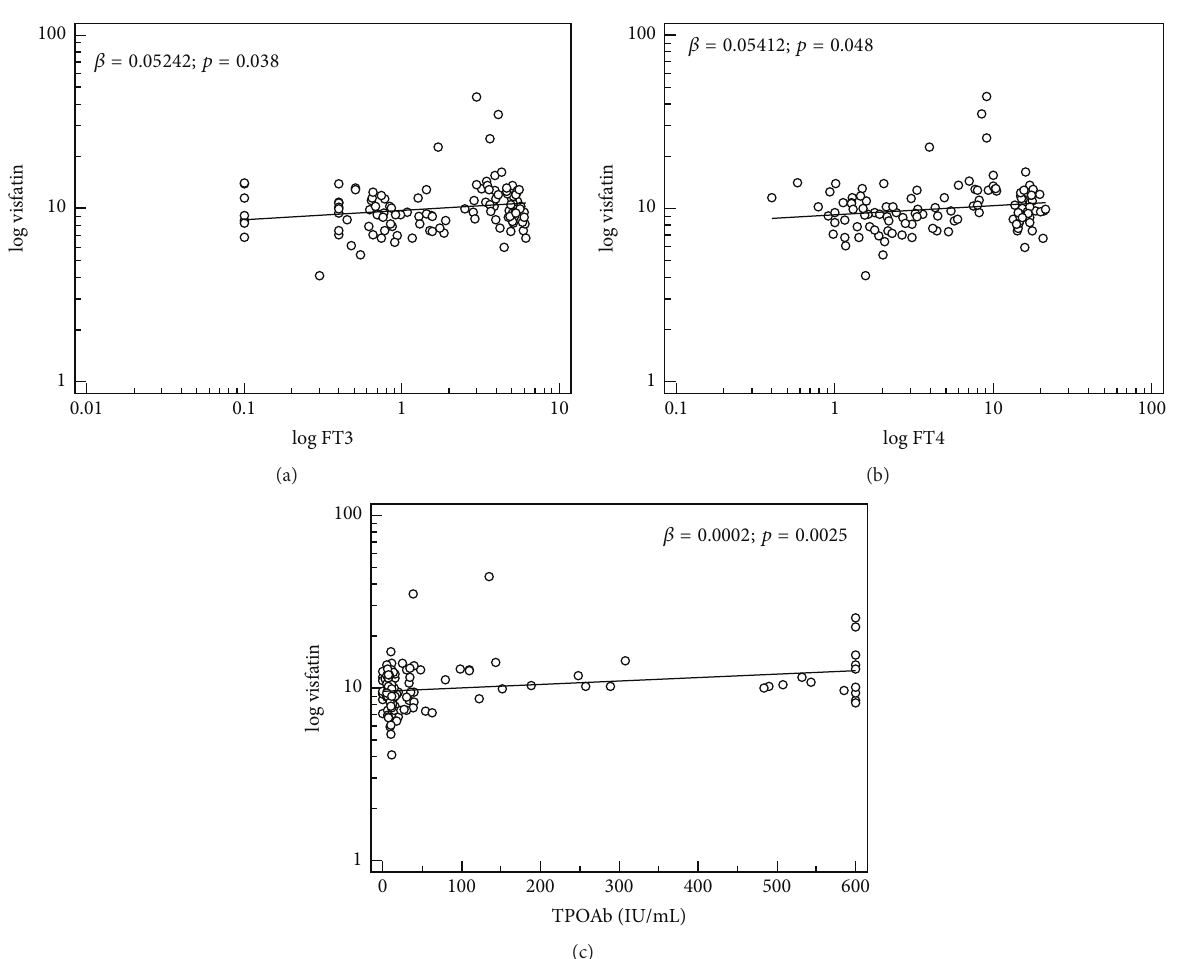
Figure 2: Association between visfatin serum level and FT3 (a), FT4 (b), and TPOAb (c). Data were log-transformed to achieve normal